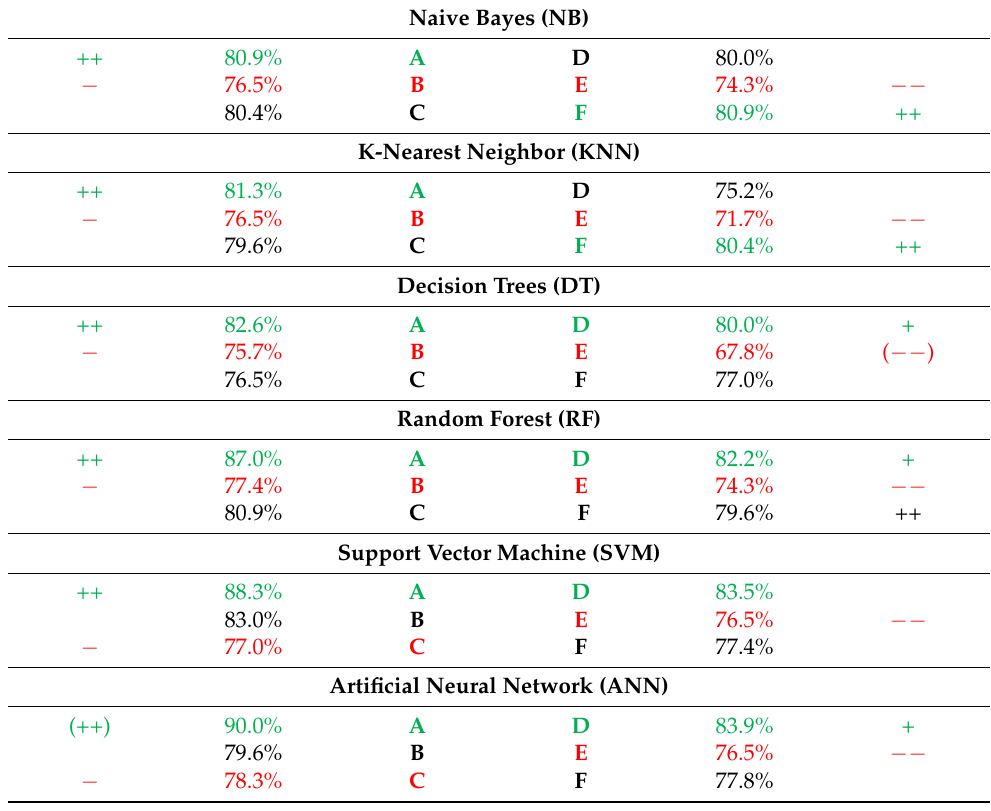
Table 4. Review of best (green) and worst (red) overall-accuracy results per machine-learning (ML) method and per algorithm. Simple techniques: naive Bayes (NB), K-nearest neighbor (KNN), and decision trees (DT). Advanced techniques: random forest (RF), support vector machine (SVM), and artificial neural network (ANN). Left column (A, B, and C): Before feature selection (Mode 1) all twelve attributes within our database. Right column (D, E, and F): After feature selection (Mode 2)— only attributes selected with Information gain (Sections 2.1.1 and 3.1). These two groups of variable sets refer to the secondary comparison level (two vertical black boxes in Figure 2, Figure 5, and Figure 6). A and D: Both attribute types (Combination 1). B and E: Only morphological information (Combination 2). C and F: Only MetOc parameters (Combination 3). These three groups of variable sets refer to the tertiary comparison level (three horizontal gray boxes in Figure 2, Figure 5, and Figure 6). Best and worst of all 36 algorithms: (++) and ( −− ). Best and worst accuracy per ML method: ++ and −− . Best and worst accuracy per technique and per feature-selection mode: + and − . See Figure 7 and Section